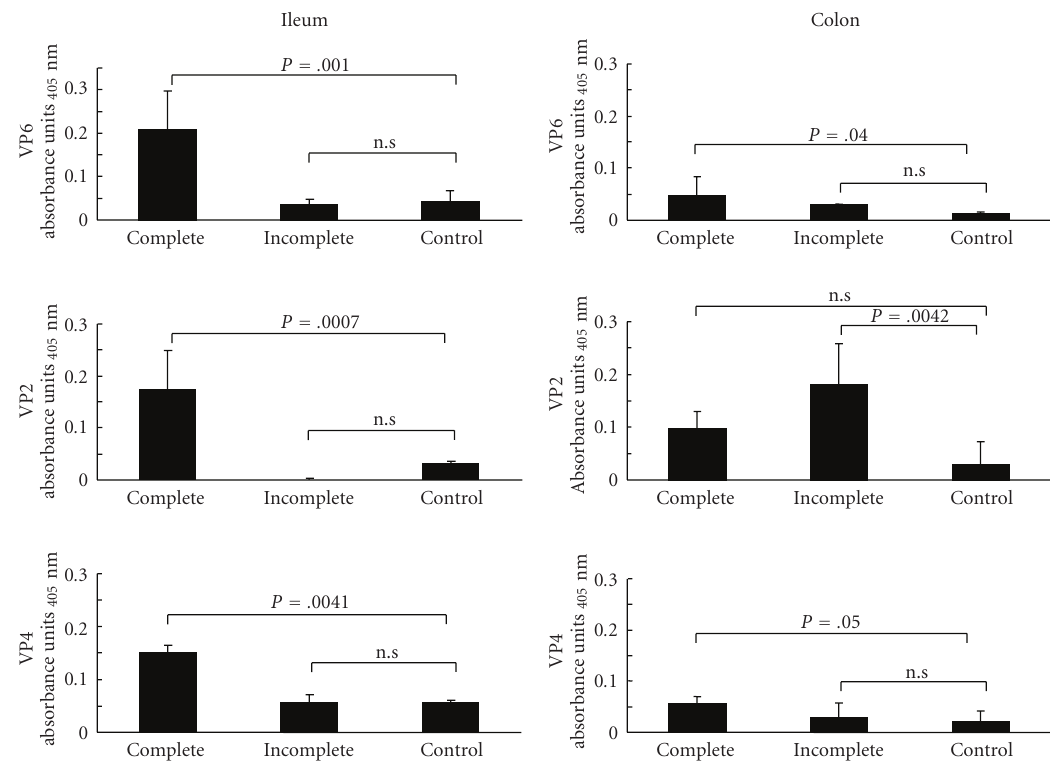
Figure 5: Quantification of viral proteins internalized in intestinal sections after VLP administration to living mice. The presence of VP2, VP4, and VP6 rotavirus proteins in the ileum and the colon of mice administered with complete VLP ( n = 4) was evaluated by ELISA. Results are expressed as absorbance units and are the mean ± sd. Dunnett’s test was used to compare treatments with the control